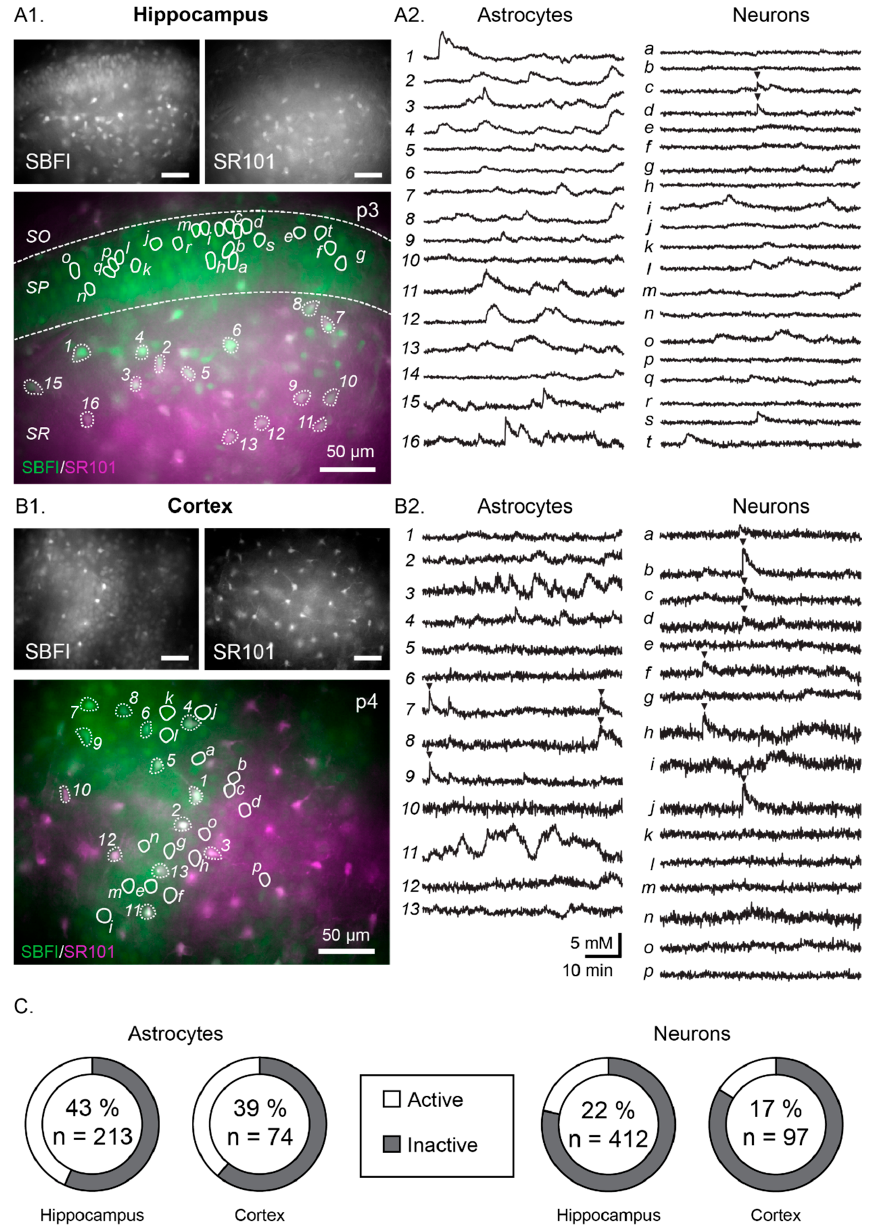
Figure 1. Example measurements showing spontaneous Na + fluctuations in the neonate hippocampus ( A1,A2 ) and neocortex ( B1,B2 ). ( A1 , B1 ) show SBFI (top left), SR101 (top right) and merge images (bottom) with all scale bars indicating 50 µ m. Circled areas correspond to regions of interest (ROIs), the individual fluorescent measurement traces of which are illustrated in A2 and B2 (astrocytes on the left and numbered, neurons on the right and labelled with letters). Arrows indicate instances when cells appear to be synchronized. ( C ) Pie charts indicating the percentage of active astrocytes (left) and neurons (right) within each area ( n = total number of cells measured). SBFI: sodium-binding benzofuran isophthalate-acetoxymethyl